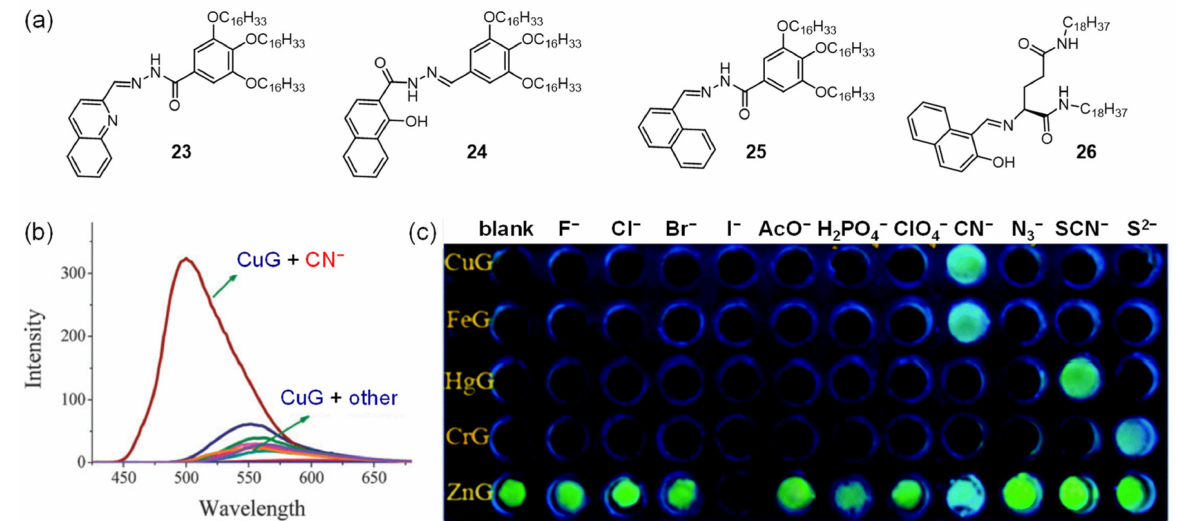
Figure 8. ( a ) Molecular structures of compounds 23 – 26 . ( b ) Fluorescence spectra of CuG (0.8%, in DMF) in the presence of various anions (F − , Cl − , Br − , I − , AcO − , H 2 PO 4 − , N 3 − , SCN − , ClO 4 − , S 2 − and CN − ) at room temperature. ( c ) Change in the color of different metallogels in the presence of 1 equiv. of various anions (using 0.1 mol L − 1 anion sodium or potassium salt water solution as anion source). Reprinted with permission from Ref. [48]. Copyright (2015), Royal Society of Chemistry.